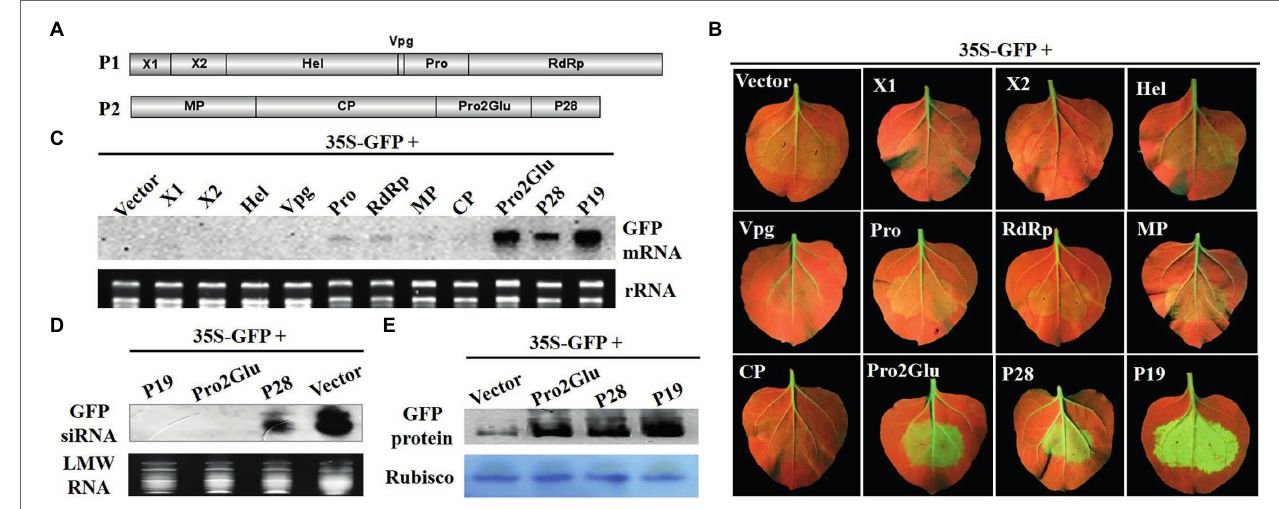
FIGURE 1 | The identification of SMoV silencing suppressor. (A) The genomic structure of SMoV. (B) The observation of GFP fluorescence in 16c Nicotiana benthamiana leaves co-infiltrated by 35S-GFP and pCHF3 vectors expressing individual proteins of SMoV at 5 days post-infiltration (dpi). The plants infiltrated with 35S-GFP and pCHF3 empty vector or pCHF3-P19 were used as negative or positive controls, respectively. (C) The analysis of GFP mRNA in infiltrated leaf patches by Northern blot at 5 dpi. DIG-labeled GFP-specific probe was used to detect the GFP mRNA. GelStain (Transgen, Beijing, China) staining was used to visualize the loading controls for the mRNA. The same below. (D) Northern blot analysis of low molecular weight (LMW) RNA from infiltrated leaf regions at 5 dpi for GFP-specific siRNA accumulation. DIG-labeled GFP-specific probe after hydrolyzing in sodium carbonate buffer was used to detect the GFP siRNA. GelStain staining was used to visualize the loading controls for the LMW RNA. The same below. (E) Western blot analysis of GFP protein in infiltrated leaf regions at 5 dpi using anti-GFP monoclonal antibody. Coomassie blue staining of the large subunit of Rubisco served as loading controls for the Western blot assay. The same